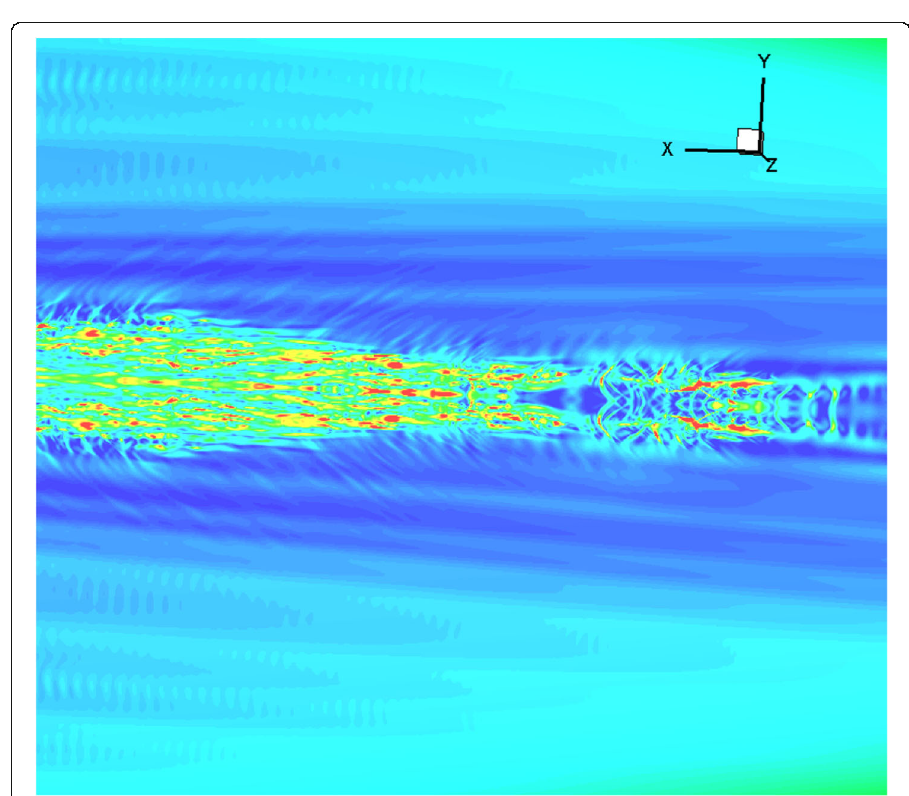
Fig. 8 Friction distribution on the lower surface: a partial enlarged view of the transition area